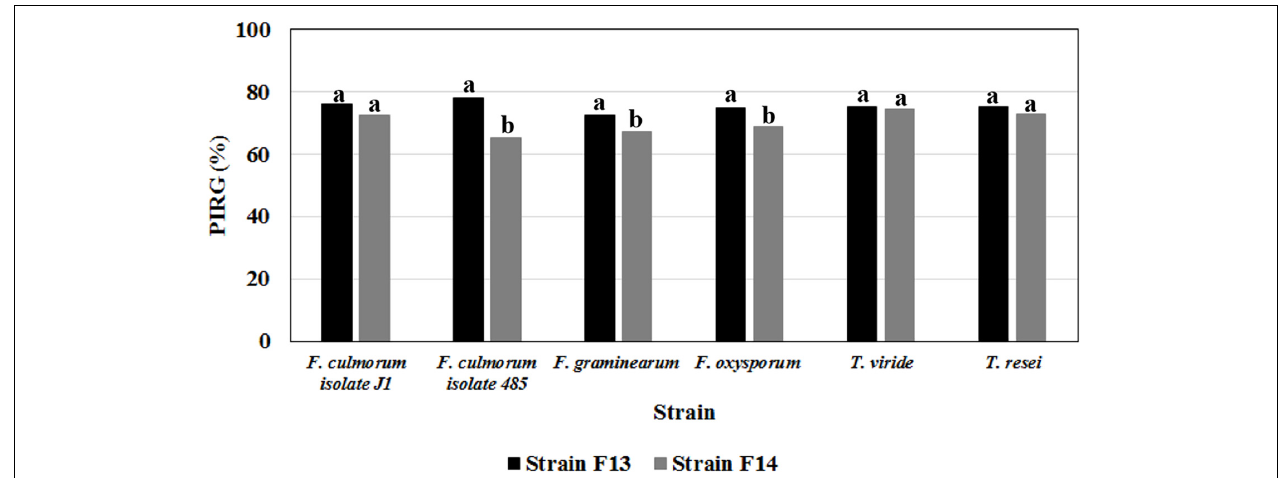
FIGURE 6 | Antifungal activities of volatile metabolites produced on LB medium by Bacillus strain F13 and F14 against mycelial cultures of different phytopathogenic Fusarium and Trichoderma species. Data are expressed in percentage of inhibition of radial growth (PIRG); values with no letter in common significantly differ at p ≤ 0.05 (Tukey HSD